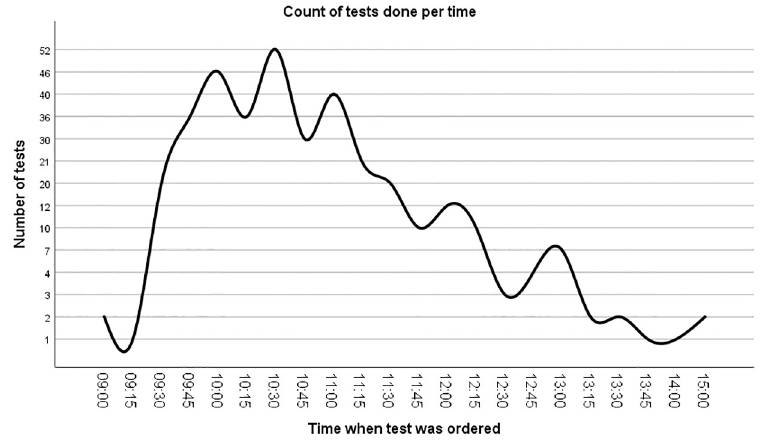
Fig 2. Tests per time. The figure shows the number of tests done per time of the